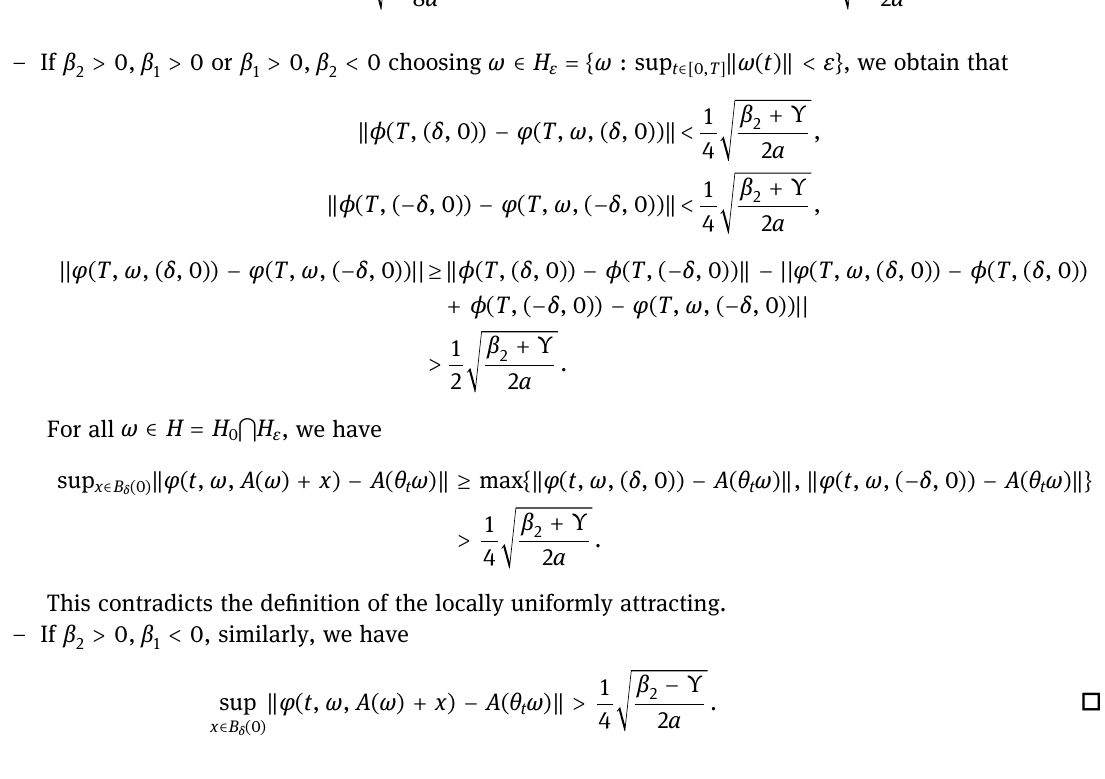
− . Figure 4 ( a ) and ( b ) focus on the point of T curve in Figure